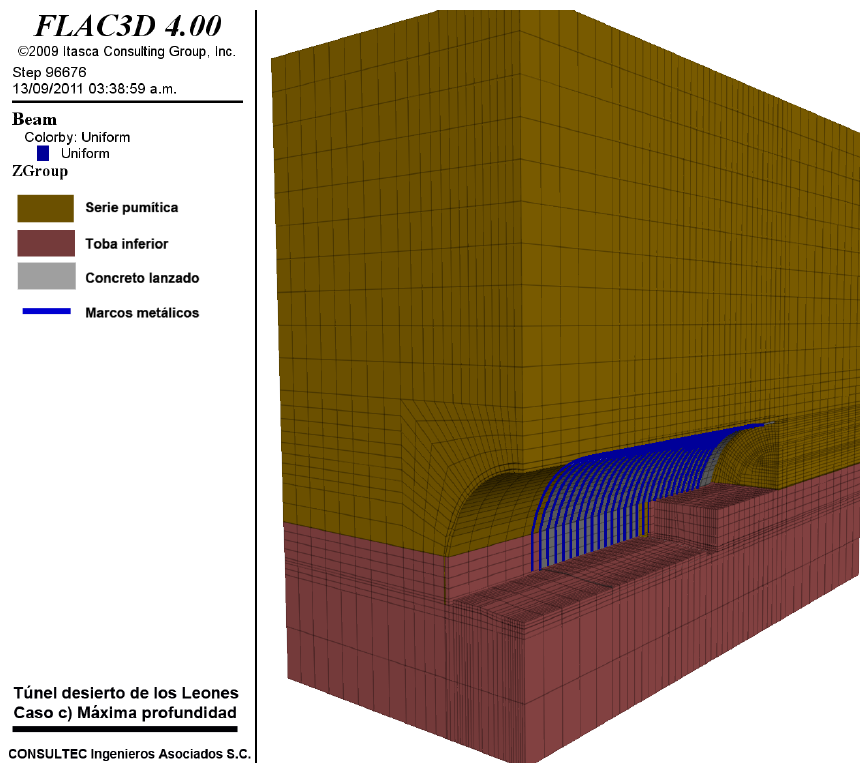
Figure 28. Mesh of finite differences for case (c). [12]. Definition terms: Serie pumitica (Pumitic se ‐ ries), Toba inferior (Lower tuff), Concreto lanzado (sprayed concrete), Marcos metalicos (steel ribs).